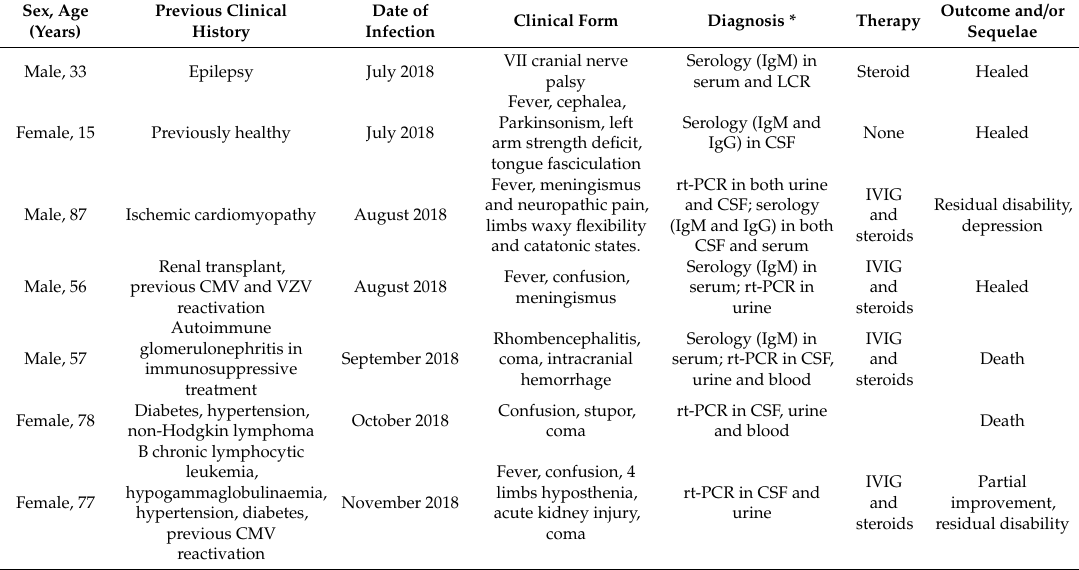
Table 1. West Nile neuroinvasive disease: A single center